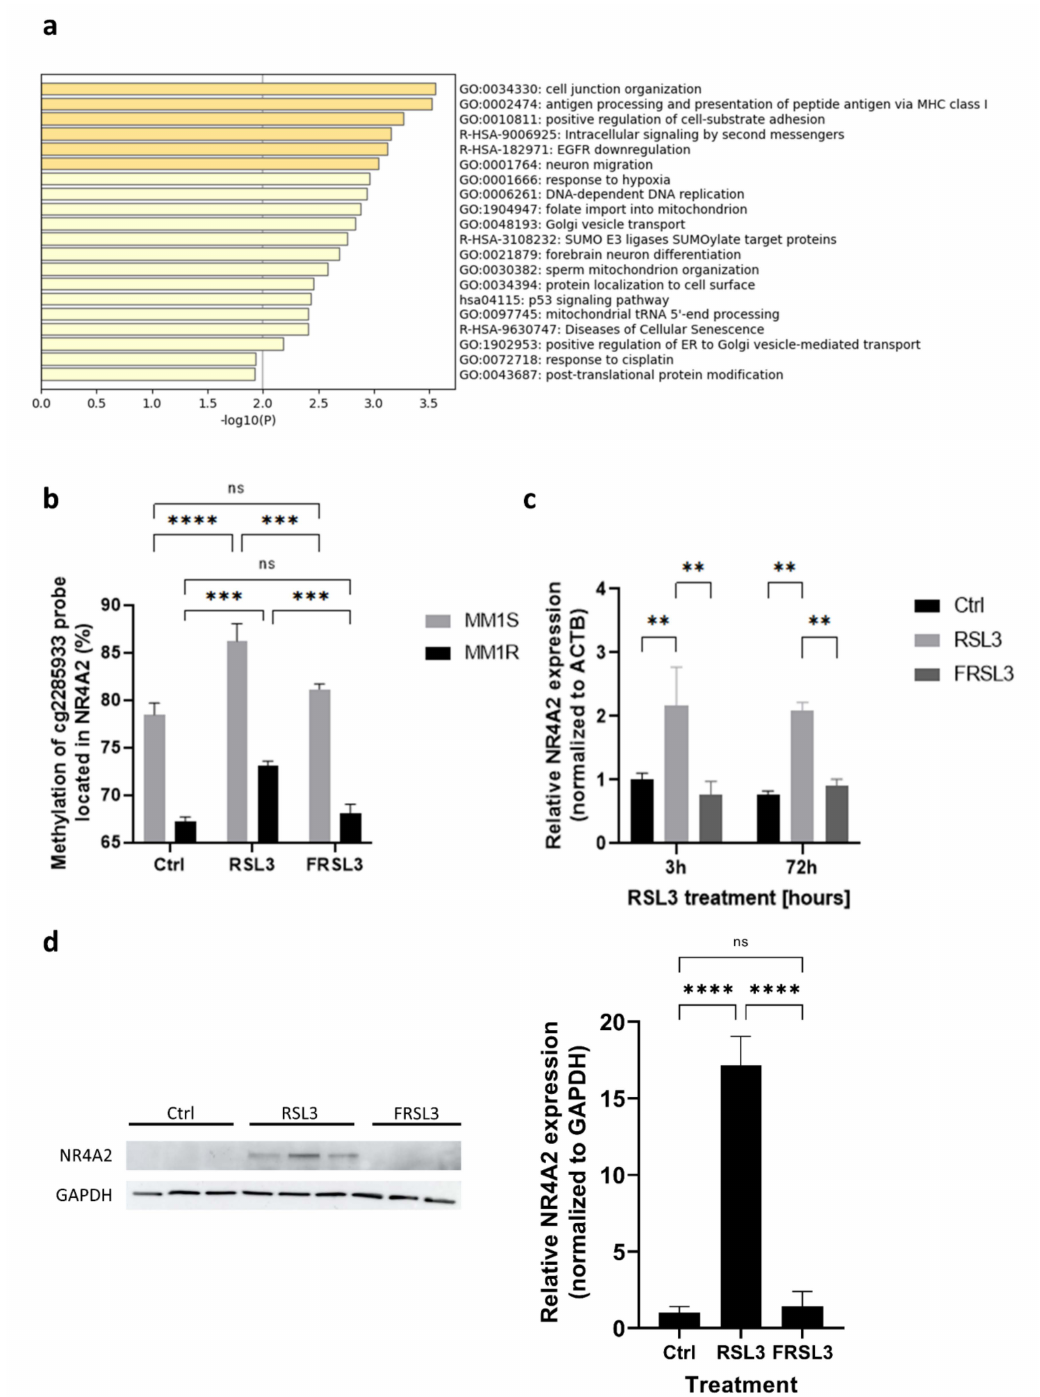
Figure 7. Ferroptosis induction results in significant methylation changes in genes associated with DNA repair and cellular senescence. ( a ) Metascape pathway analysis [44] of genes associated with the top significant (FDR < 0.01) differentially methylated CpG probes in MM1 cells after RSL3 treatment. ( b ) Mean methylation levels (%) of CpG probe cg2285933 located in the S shelf of the NR4A2 gene as determined by pyrosequencing. Data are represented as mean methylation levels ± s.d., n = 3 biologically independent replicates per cell line (*** p < 0.001, **** p < 0.0001). ( c ) Relative NR4A2 mRNA expression in MM1 cells after treatment with RSL3. Data are plotted as the mean ± s.d., n = 3 biologically independent replicates (** p < 0.01). ( d ) Western blot detection and quantification of NR4A2 and GAPDH expression levels after RSL3 treatment in MM1 cells. Data are plotted as the mean ± s.d., n = 3 biologically independent replicates per cell line (ns = p > 0.05, **** p < 0.0001,